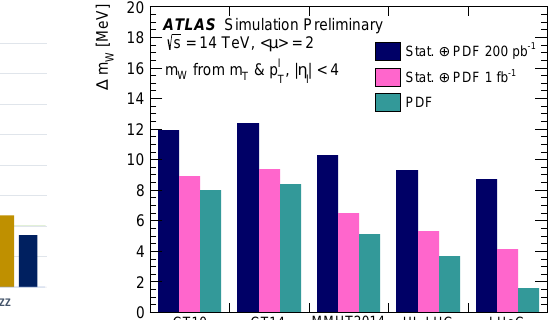
(right), by greater W